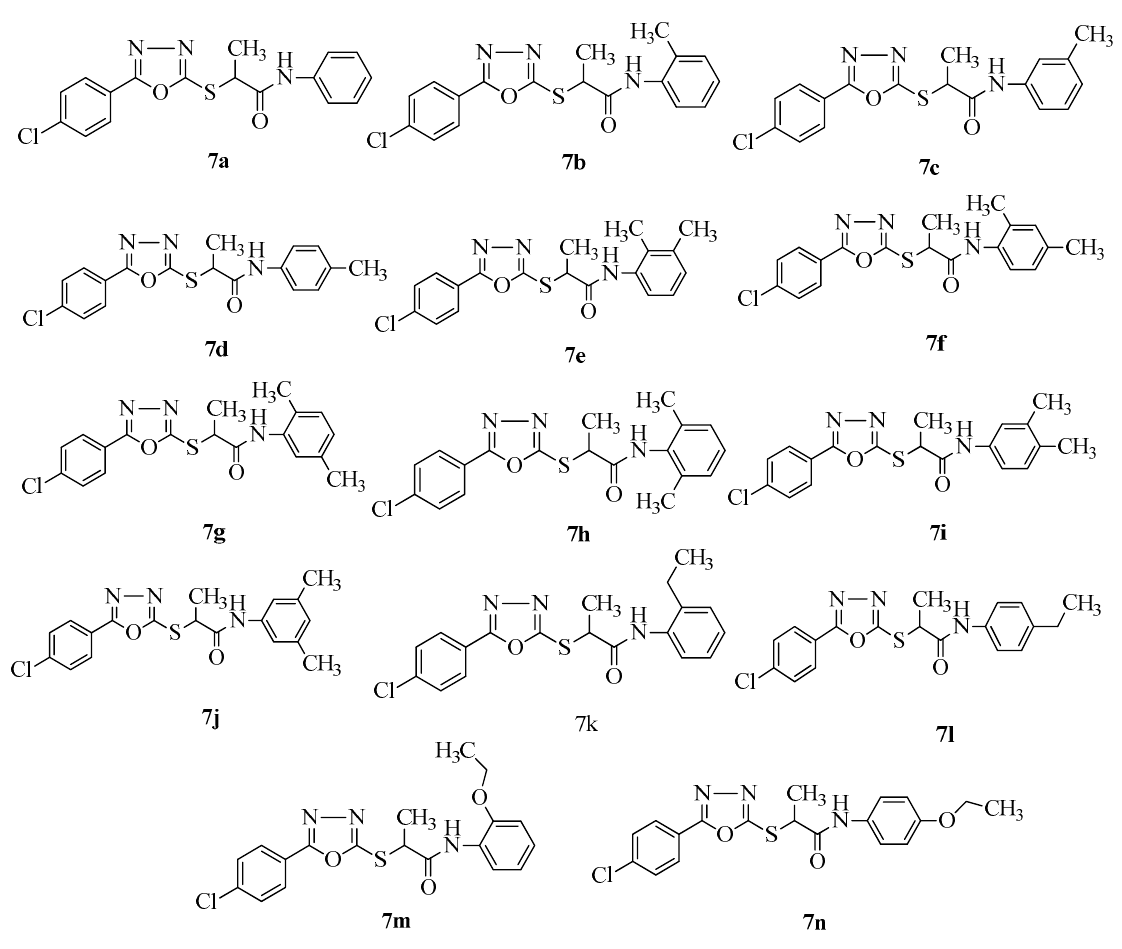
Figure 2. Chemical structures of the selected 1, 3, 4 oxadiazole derivatives [16].